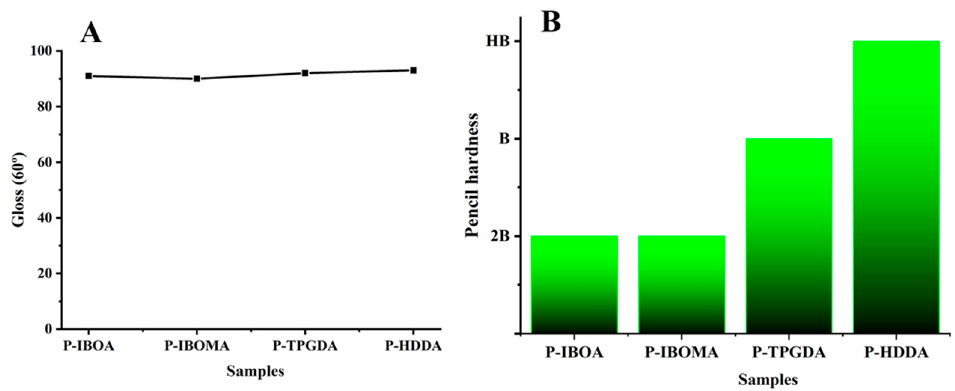
Figure 8. ( A ) Gloss values at an angle of 60° and ( B ) pencil hardness of UC-cured PUA coating films.